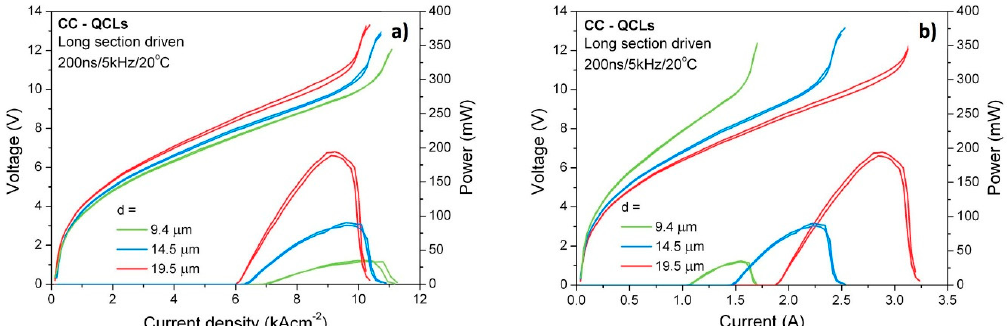
Figure 4. L–I–V curves of reactive ion etching (RIE) fabricated CC-QCLs with different active area width: 9.4 µm (green line), 14.5 µm (blue line), 19.5 µm (red line). Light-voltage curves vs. current ( a ), Light-voltage curves vs. current density ( b ).